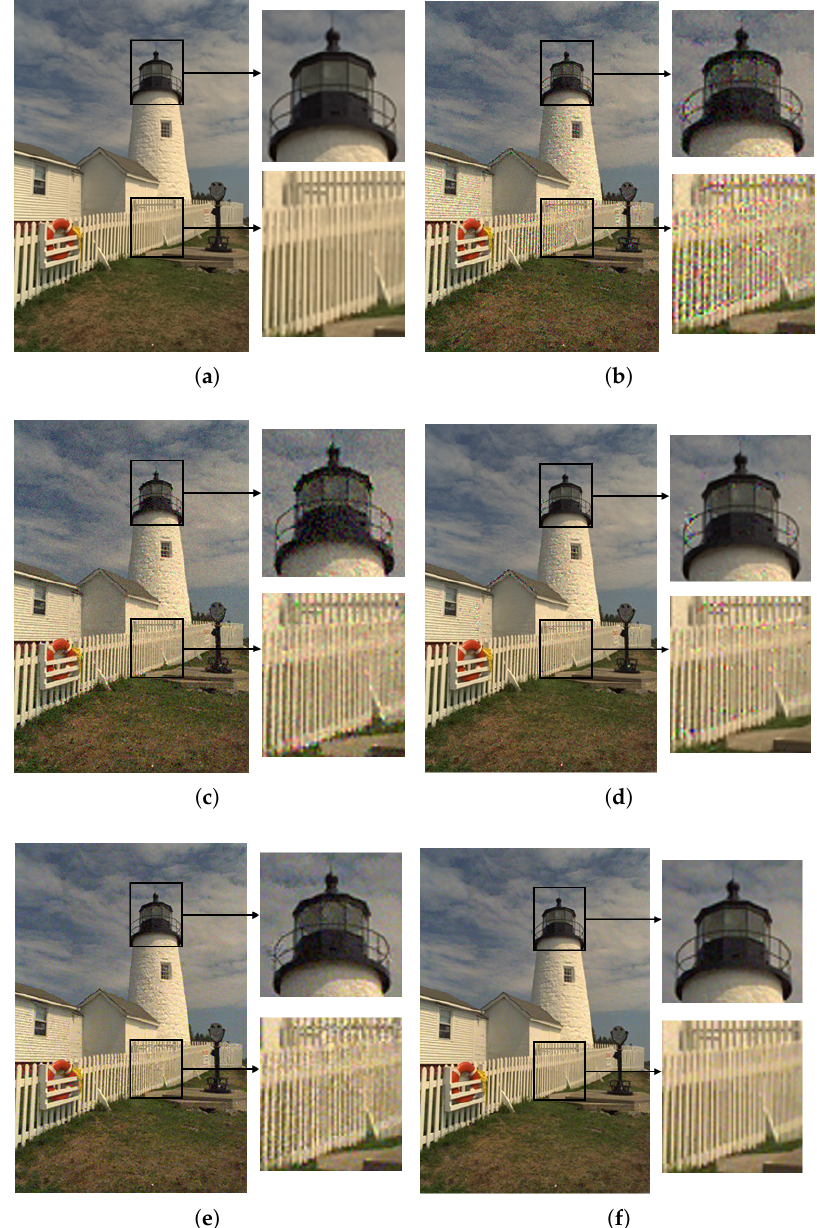
Figure 5. An example of the comparison of contaminated images from different JND models. The contaminated images have the same level of noise, with PSNR = 28.91 dB. ( a ) The original image; ( b ) Wu2013, VMAF = 82.65; ( c ) Wu2017, VMAF = 83.41; ( d ) Chen2019, VMAF = 87.44; ( e ) Jiang2022, VMAF = 90.34; and ( f ) The proposed CSJND model, VMAF =